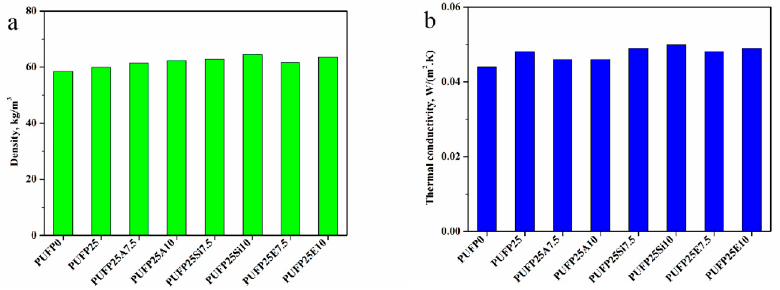
Figure 11. Density ( a ) and thermal conductivity ( b ) of RPUF.